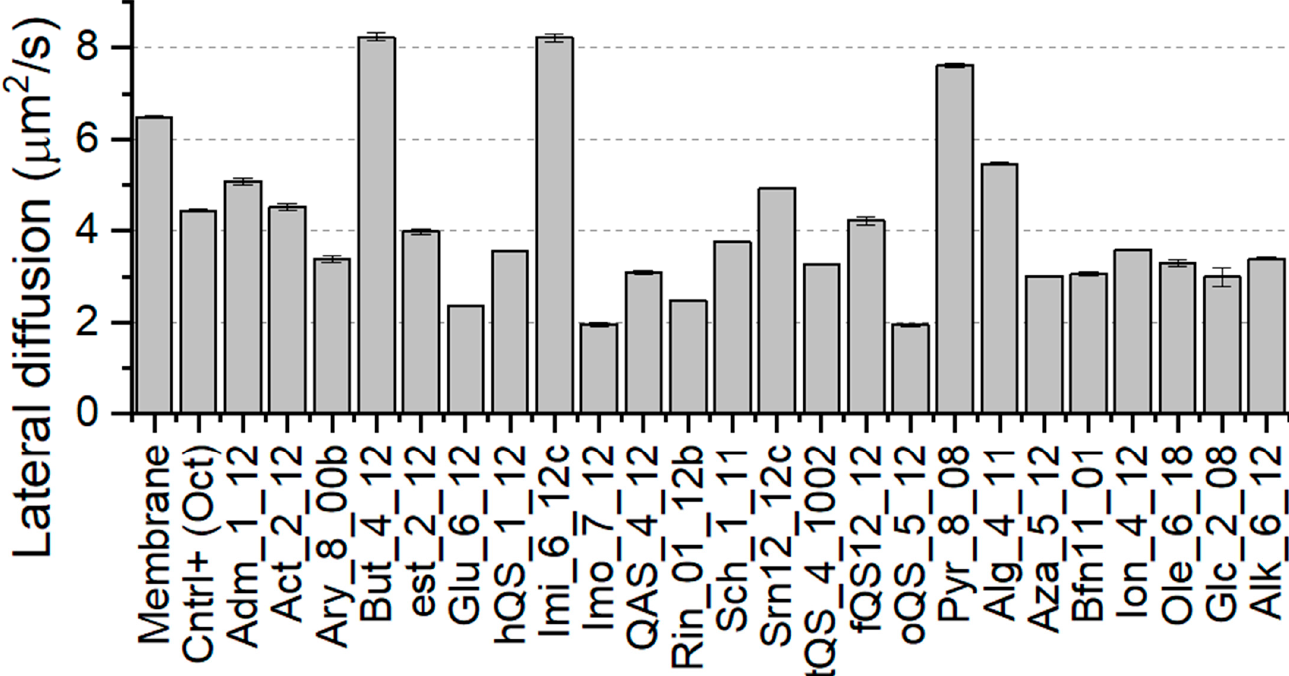
Figure 5. Determined values of lateral diffusion (2D) for membrane systems with incorporated Gemini molecules.